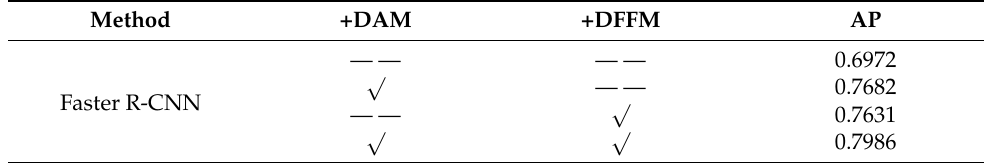
Table 3. Comparison of different